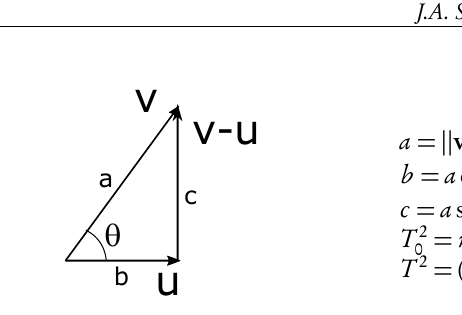
Figure 1 – Geometric representation of the test statistics T